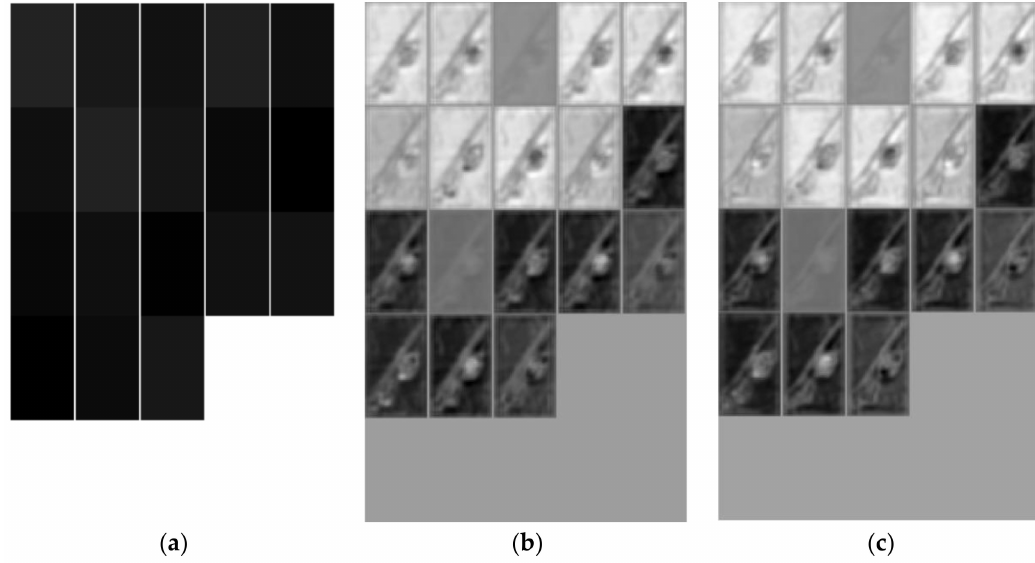
Figure 6. Visualization of feature maps of different feature extraction networks. ( a ): ZF Net; ( b ) VGG16; ( c )